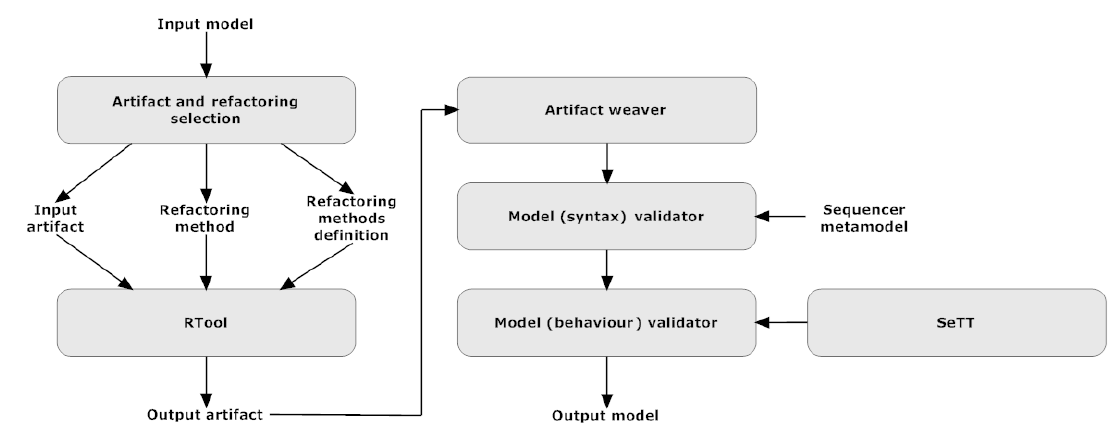
Figure 5. Model transformation for refactoring in